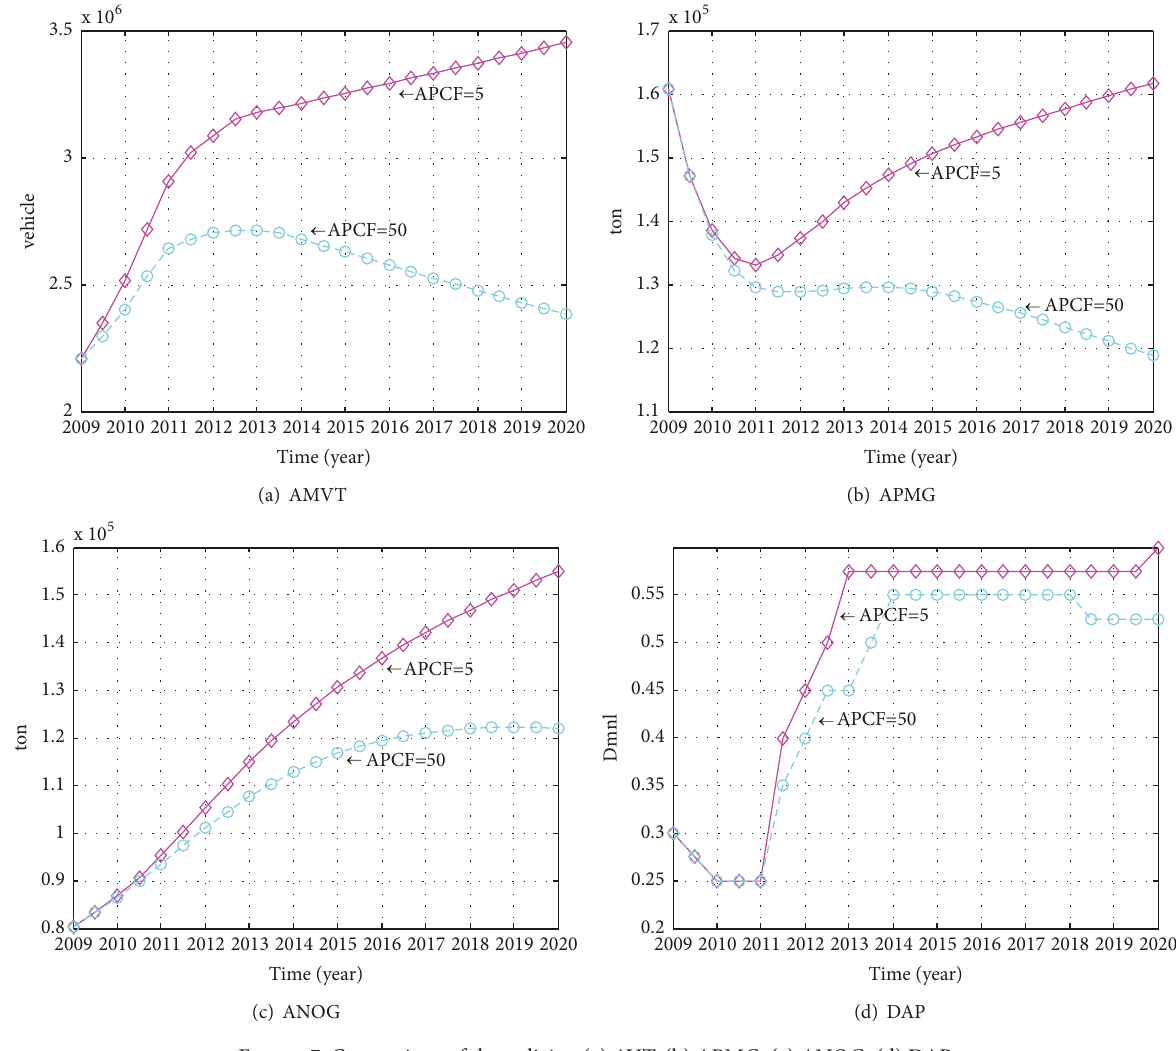
Figure 7: Comparison of the policies. (a) AVT. (b) APMG. (c) ANOG. (d)